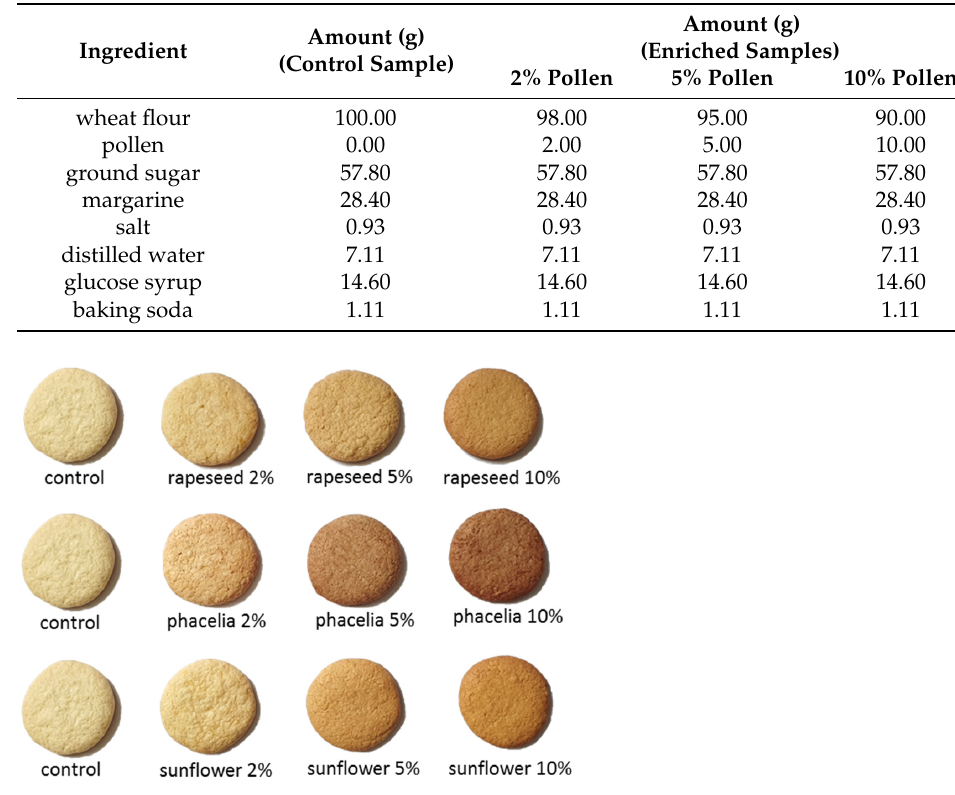
Table 1. Raw materials used for biscuit preparation.